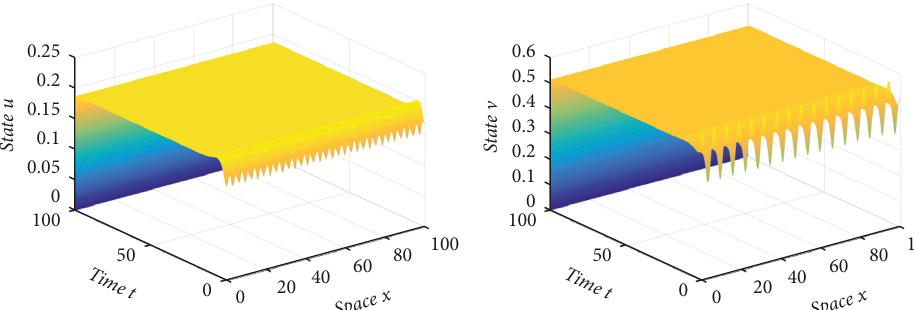
Figure 3: Spatiotemporal evolution behaviors of prey and predator of system (10) with D u ( 0 ,x ) � 0 . 187 + 0 . 1 cos x, v ( 0 , x ) � 0 . 515 + 0 . 4 cos x